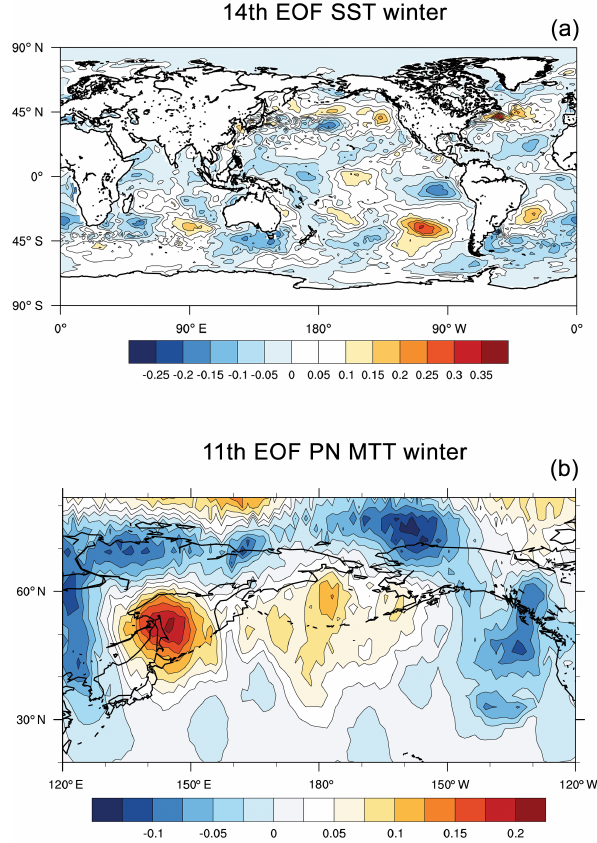
Figure 4. (a) The spatial pattern (EOF) associated with the 14th PC of the SST winter field used for the prediction Niño3.4 Index. (b) the spatial pattern (EOF) associated with the 11th PC of MTT winter field that was also used for those